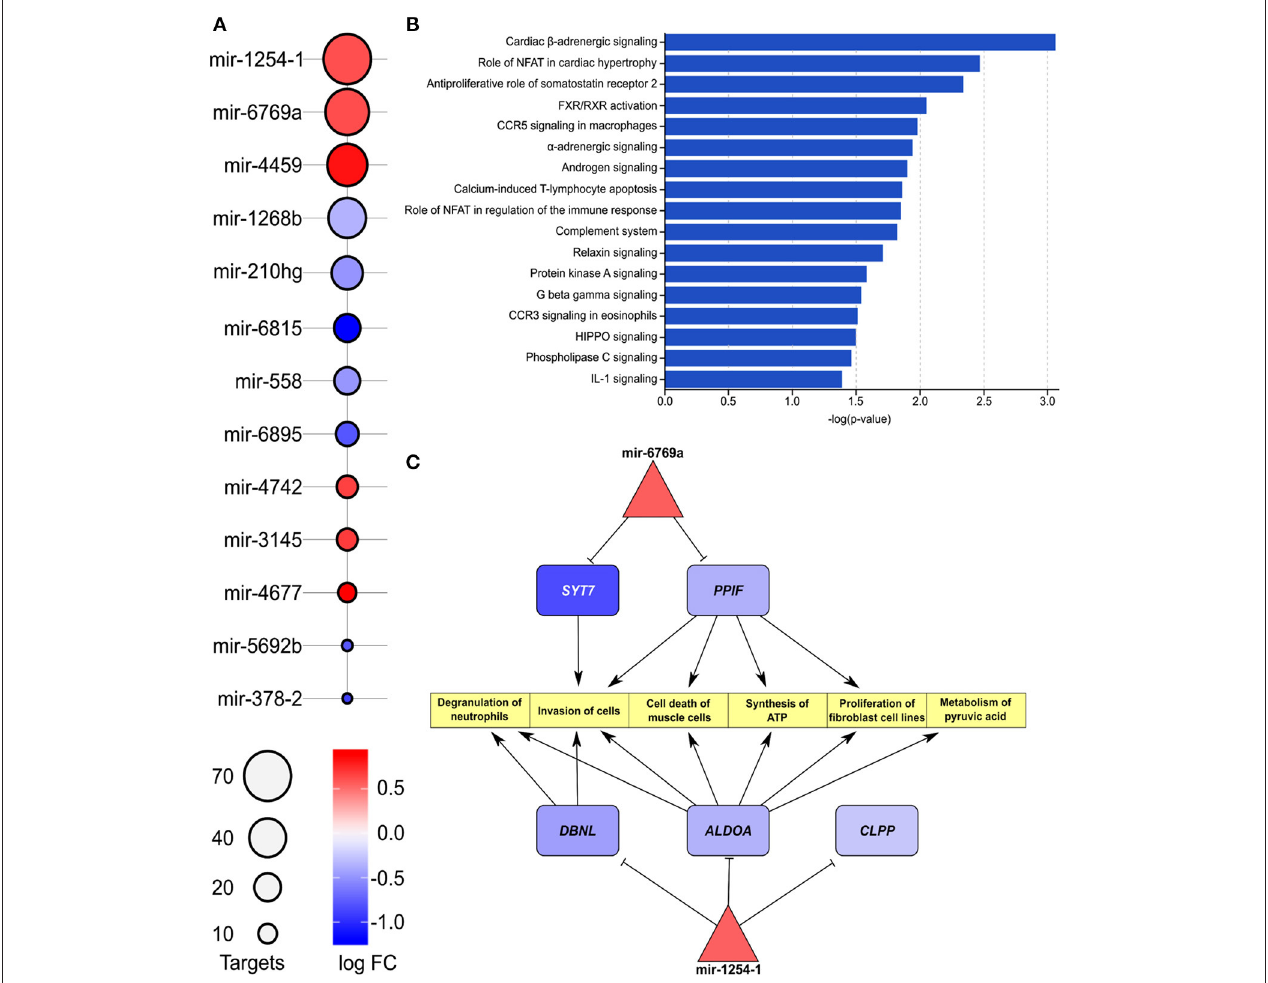
FIGURE 3 | (A) List of enriched miRNAs in IHD vs. non-IHD patients. Color key, log FC; bubble plot, number of targets. (B) List of pathways related to enriched miRNAs. The bars express –log( p -value). (C) Differentially expressed downstream target genes and pathways related to hsa-mir-1254-1 and hsa-mir-6769a.